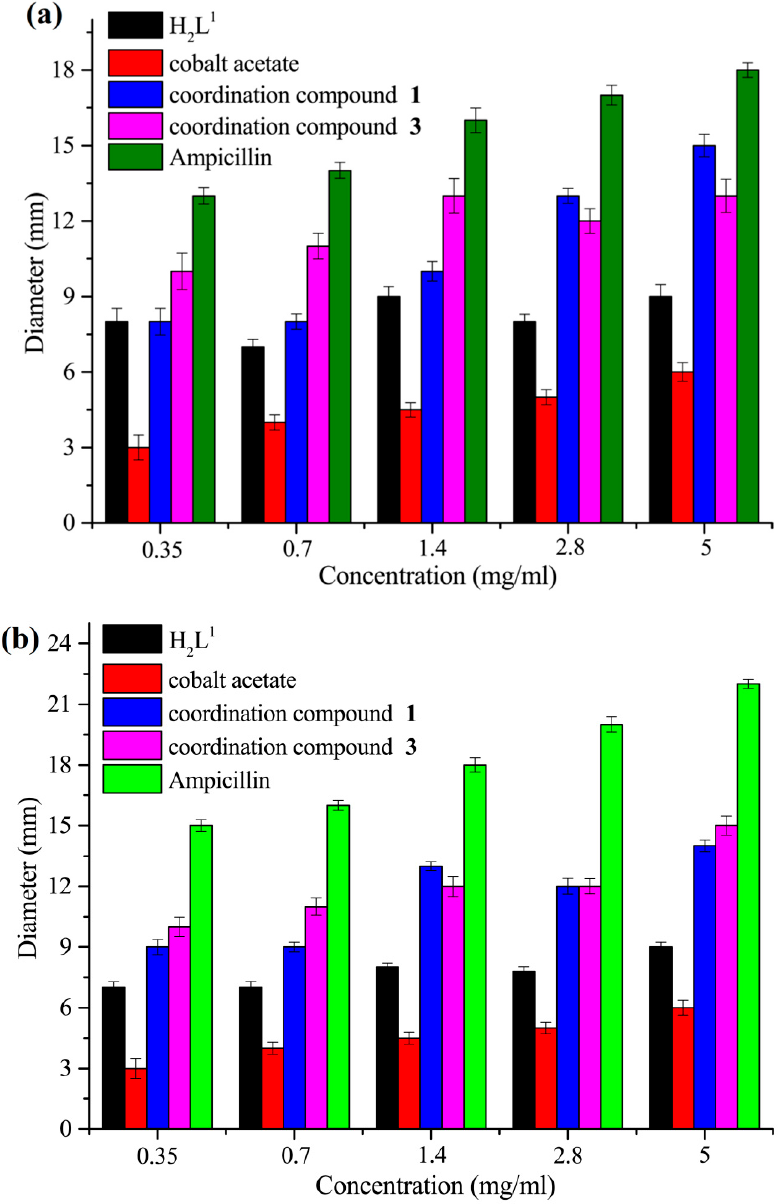
Figure 9. The diameter of inhibition zones of E. coli ( a ) and S. aureus ( b ) at different